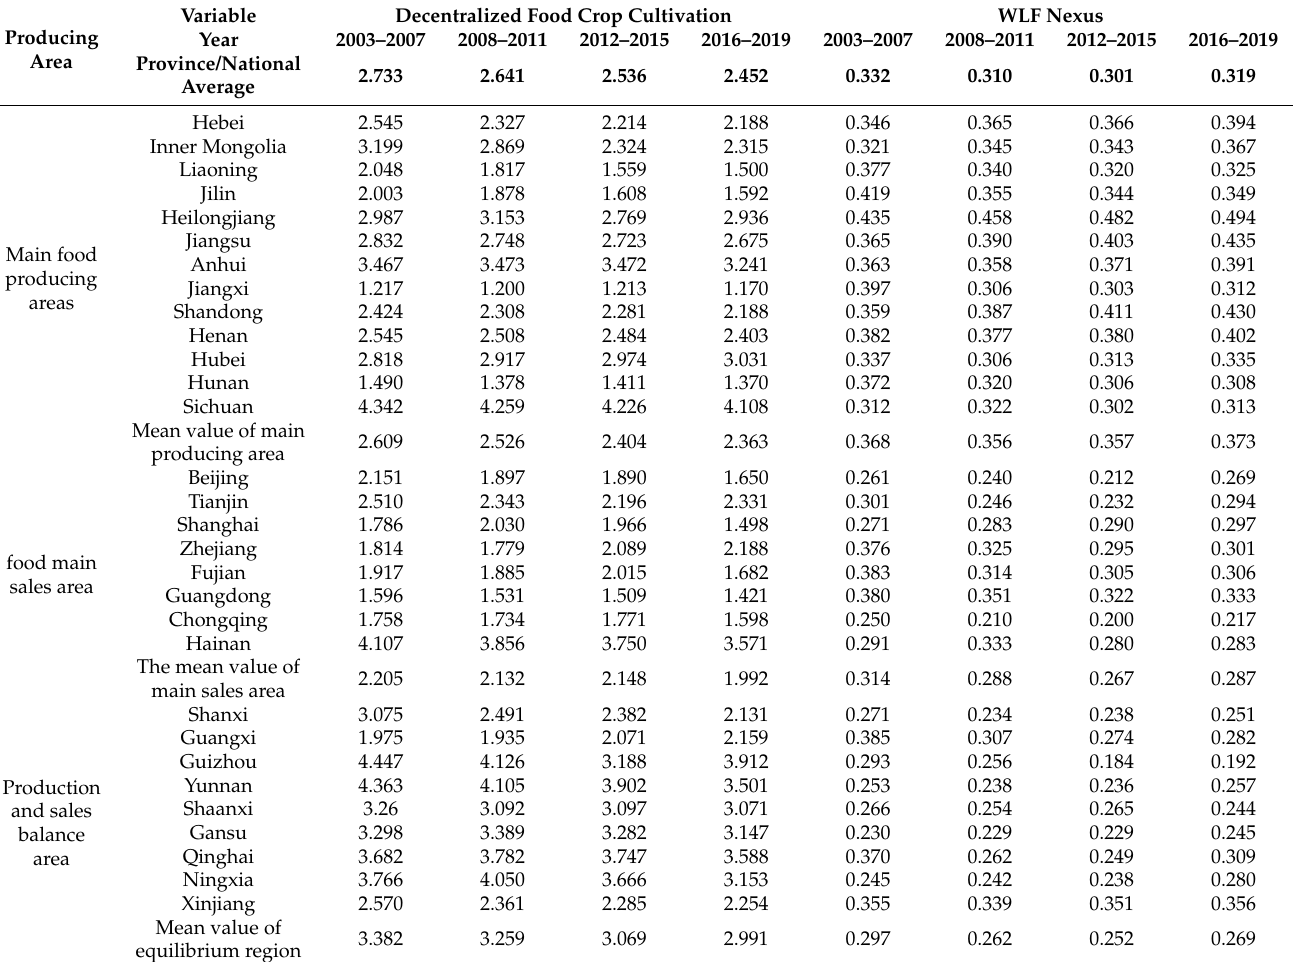
Table 2. Distributional characteristics of decentralized food crop cultivation and WLF